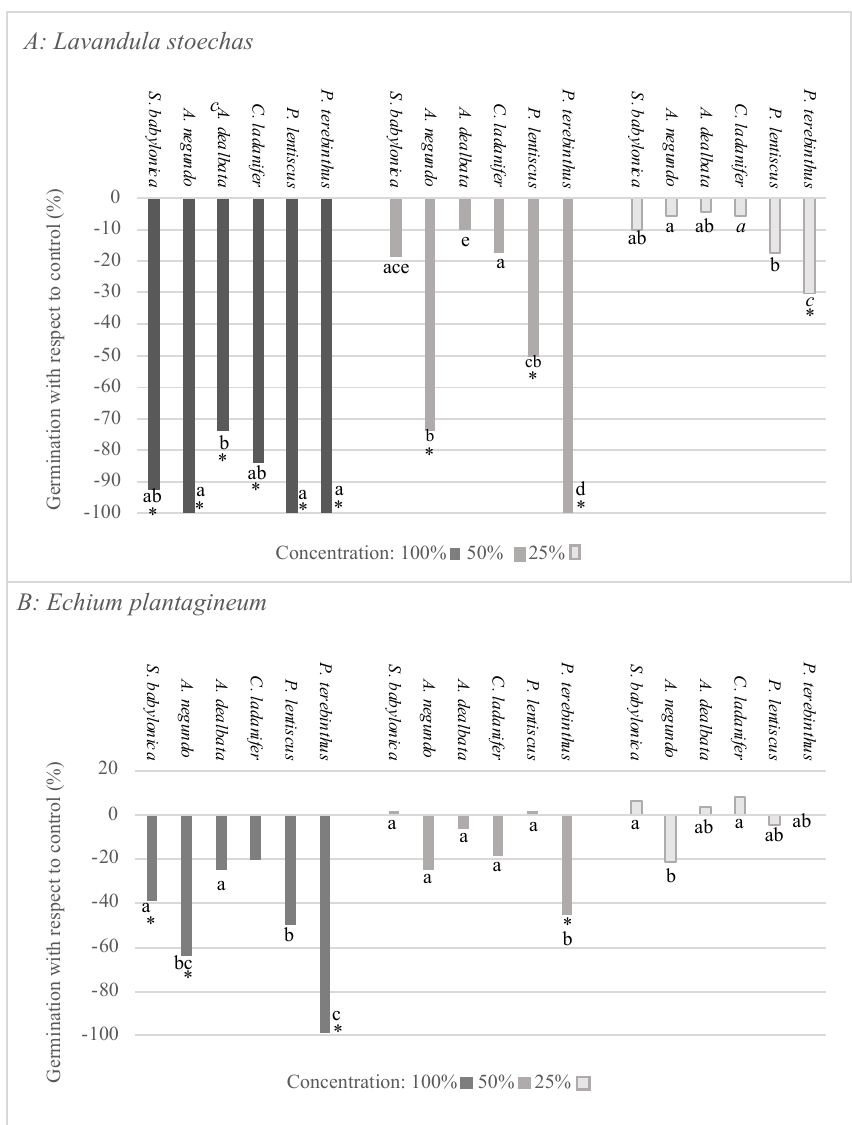
Figure 2. Effect of S. babylonica , A. negundo , A. dealbata , C. ladanifer , P. lentiscus , and P. terebinthus extract on germination of L. stoechas ( A ) and E. plantagineum ( B ) at 100%, 50%, and 25% concentrations; a, b, c, d, e: lowercase letters indicate significant differences between species on the same concentration (Mann-Whitney test, p < 0.05). *: Significant difference of control (Mann-Whitney test, p < 0.05). Regarding the effect on the germination of E. plantagineum (Figure 2B), the extracts of species P. lentiscus , A. dealbata , and C. ladanifer did not exert significant inhibition at any concentration; A. negundo and S. babylonica only showed significant inhibition at the maximum concentration, and P. terebinthus exerted significant inhibition at 100% and 50%. The quantification of the effect on root size (Figure 3A,B) revealed that both L. stoechas and E. plantagineum were negatively affected by all species at all extract concentrations, although there were significant differences between species. The root size of L. stoechas was significantly inhibited by A. negundo , P. lentiscus, and P. terebinthus , and that of E. planagineum was significantly inhibited by the extracts of A. negundo , C. ladanifer , P. lentiscus, and P. terebinthus . It is worth highlighting that P. terebinthus was the species that most negatively affected both target species, whereas S. babylonica and A. dealbata showed the lowest